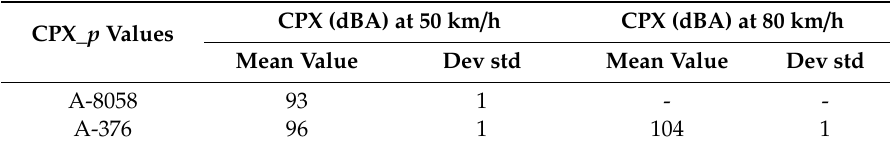
Table 3. Close proximity (CPX) method values measured in both test tracks at the beginning of the project. CPX (dBA) at 50 km/h CPX (dBA) at 80 km/h CPX_ p Values Mean Value Dev std Mean Value Dev std A-8058 93 1 - - A-376 96 1 104 1